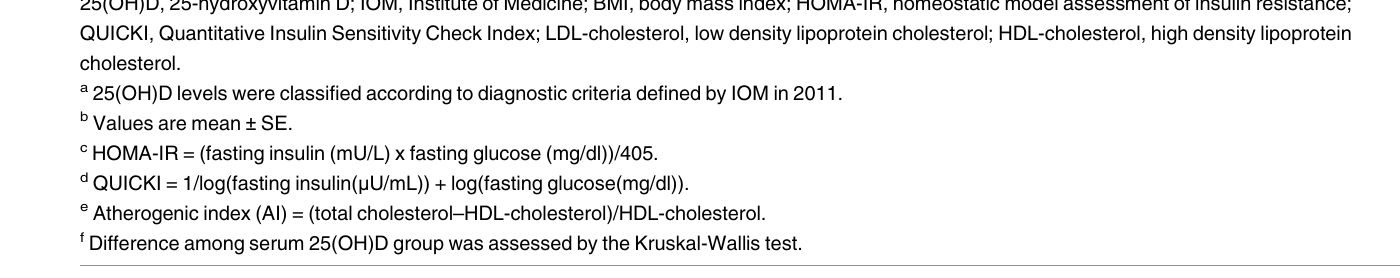
Metabolic outcomes by serum vitamin D status The metabolic outcomes of Korean prediabetic adults by serum 25(OH)D level are shown in Table 2. The mean BMI of all subjects was 25.4 ± 0.5 kg/m 2 . There was significant association between serum 25(OH)D level and atherogenic index (AI) in females only (p = 0.038).